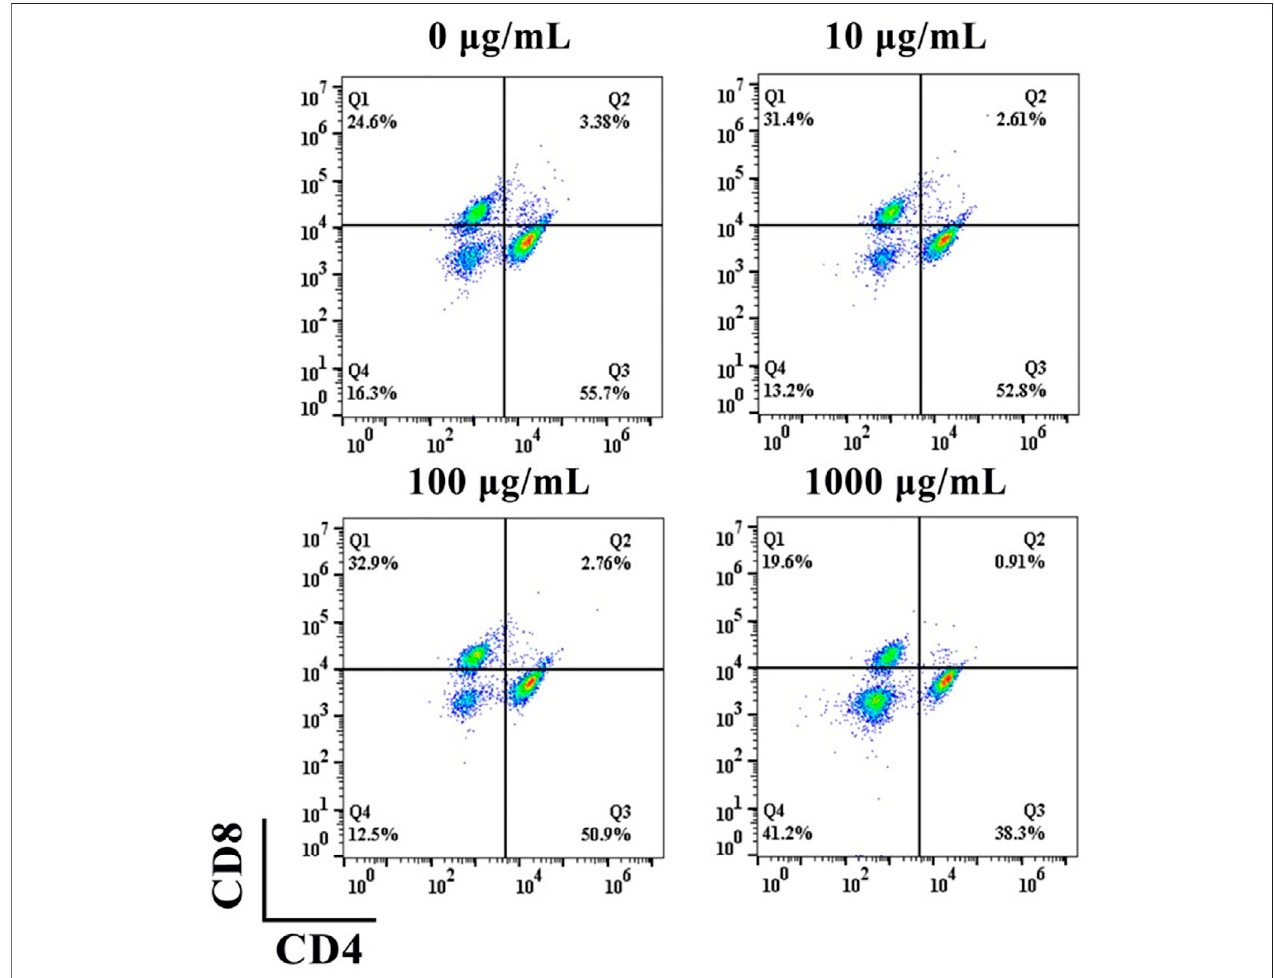
FIGURE 4 | Flow cytometry analysis of the effect of nHA on T cell differentiation.